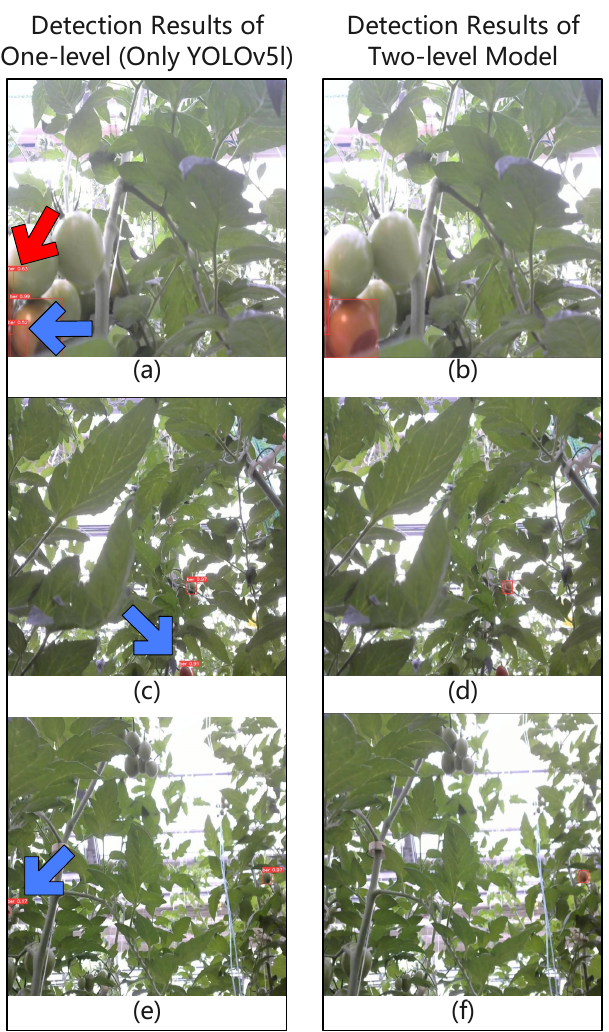
Figure 14. The detection results when the confidence threshold is set to 0.1. The two-level detection model successfully removes the false detection results pointed out by the blue arrow. The incorrect detection result pointed out by the red arrows is incorrectly retained. ( a , c , e ) Detection results of YOLOv5l; ( b , d , f ) detection results of the two-level